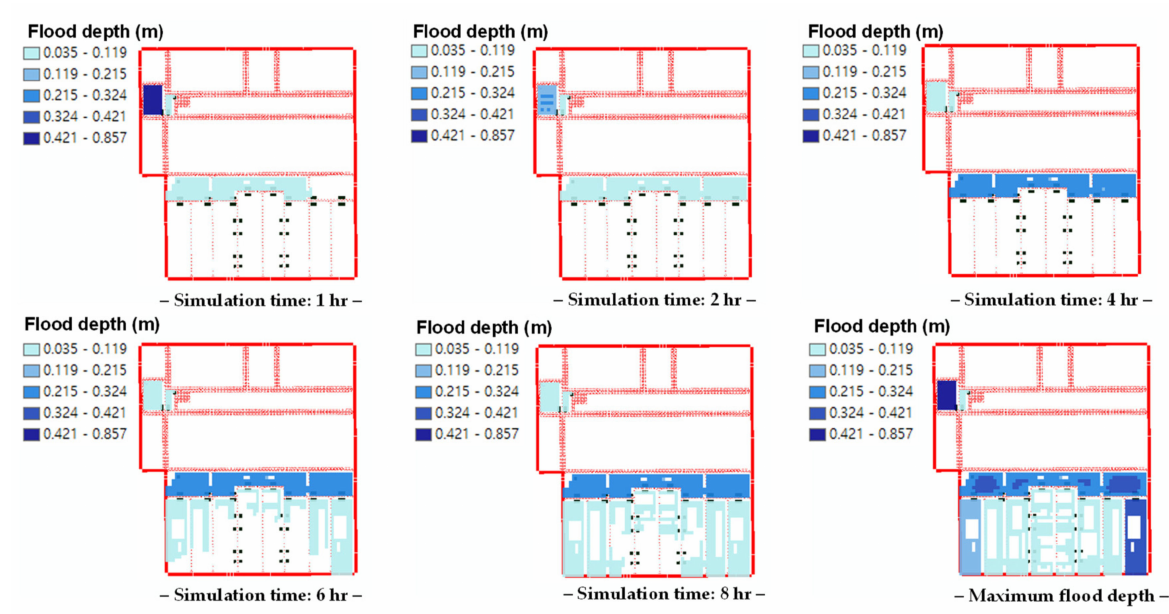
Figure 11. 2D internal flood analysis for a return period of 10 7 years (NPP 3).